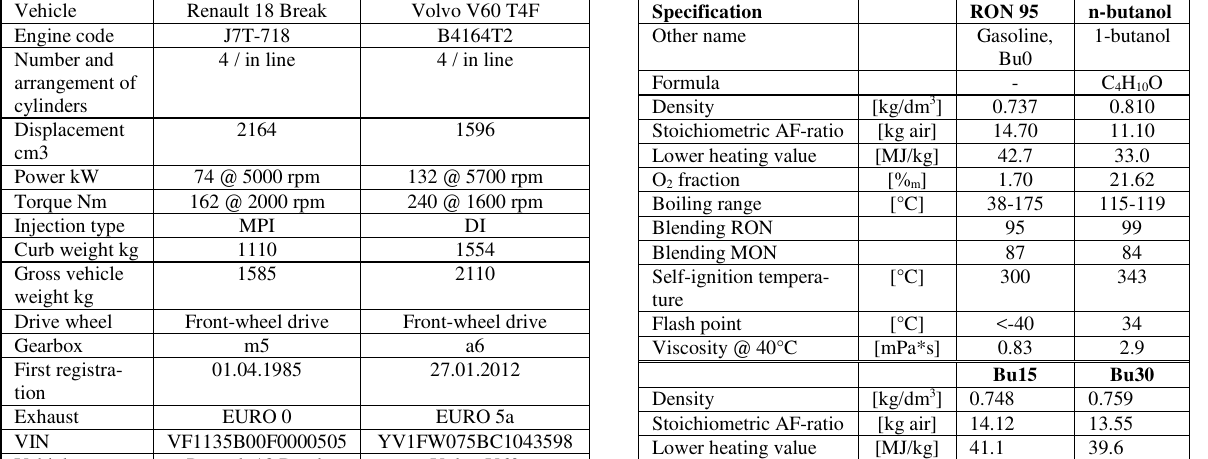
Fig. 1. Gasoline vehicles for research of emissions Table 1. Data of tested vehicles Table 2. Fuel properties of the test